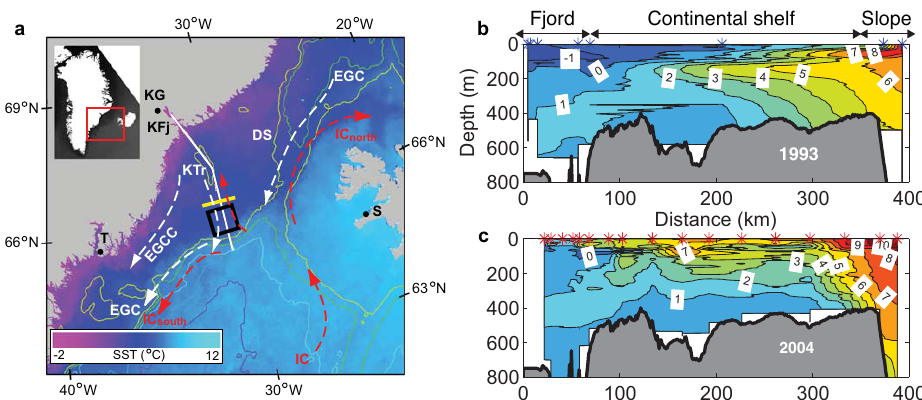
Fig. 1. (a) Map of central East Greenland and regions near Denmark Strait (DS). KG, KFj and KTr mark locations of Kangerdlugssuaq Glacier, Kangerdlugssuaq Fjord and Kangerdlugssuaq Trough. White solid line shows hydrographic transect for the vertical sections shown in (b) (1993) and (c) (2004). Black box represents the area used to compute temperature and salinity at depth. The yellow line is a transect used to calculate variations in oceanic heat flux. Dashed arrows illustrate paths of the Irminger Current (IR), East Greenland Current (EGC) and East Greenland Coastal Current (EGCC). Colours illustrate whether currents are warm (red) or cold (white). Contours mark bathymetry in 500m intervals and the background colour scheme shows sea-surface temperature in August 2004 from Oceancolor SST climatology. Black dots mark location of Tasiilaq (T) and Stykkish´olmur (S). (b) Vertical section showing potential temperature of water masses in KFj and KTr in September 1993. (c) Same as (b) , but for observations in September 2004. The topographic overlay is the observed bathymetry in KFj and along